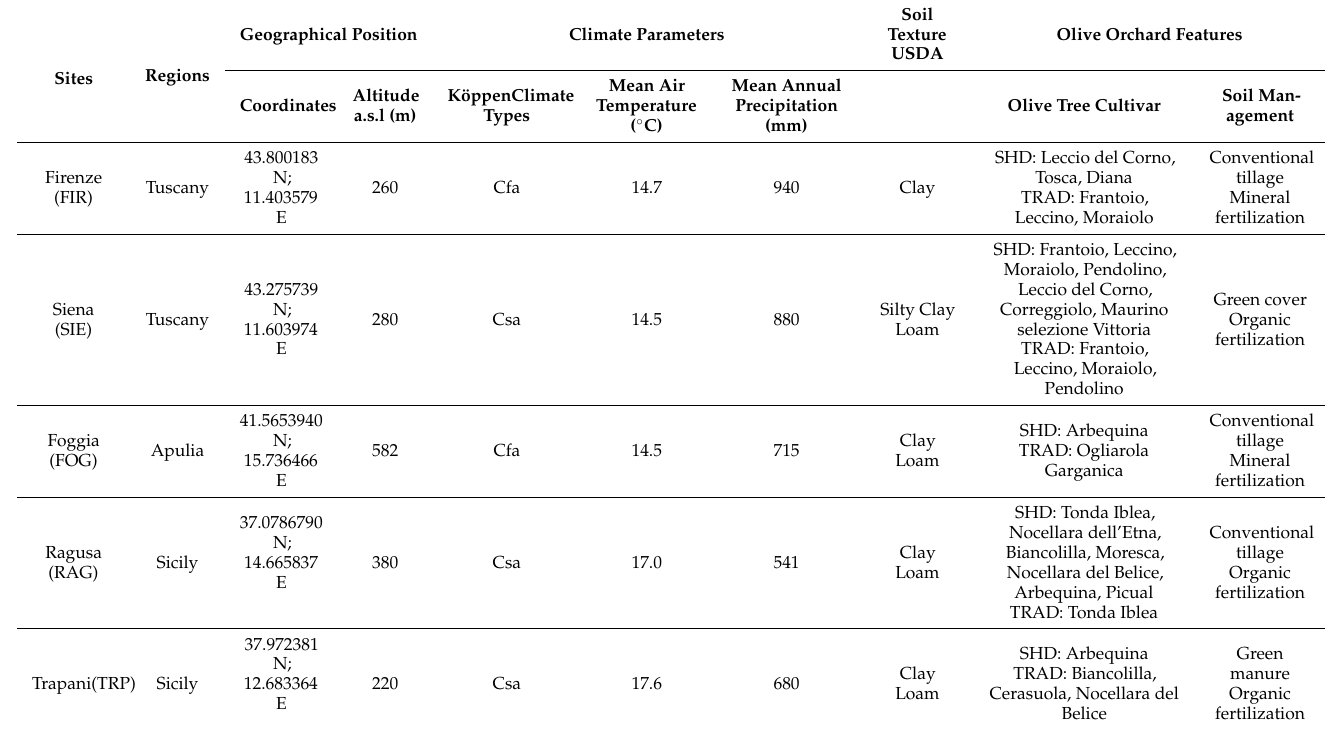
Table 1. Geographical position, climate parameters, soil texture, and olive orchard features of the experimental